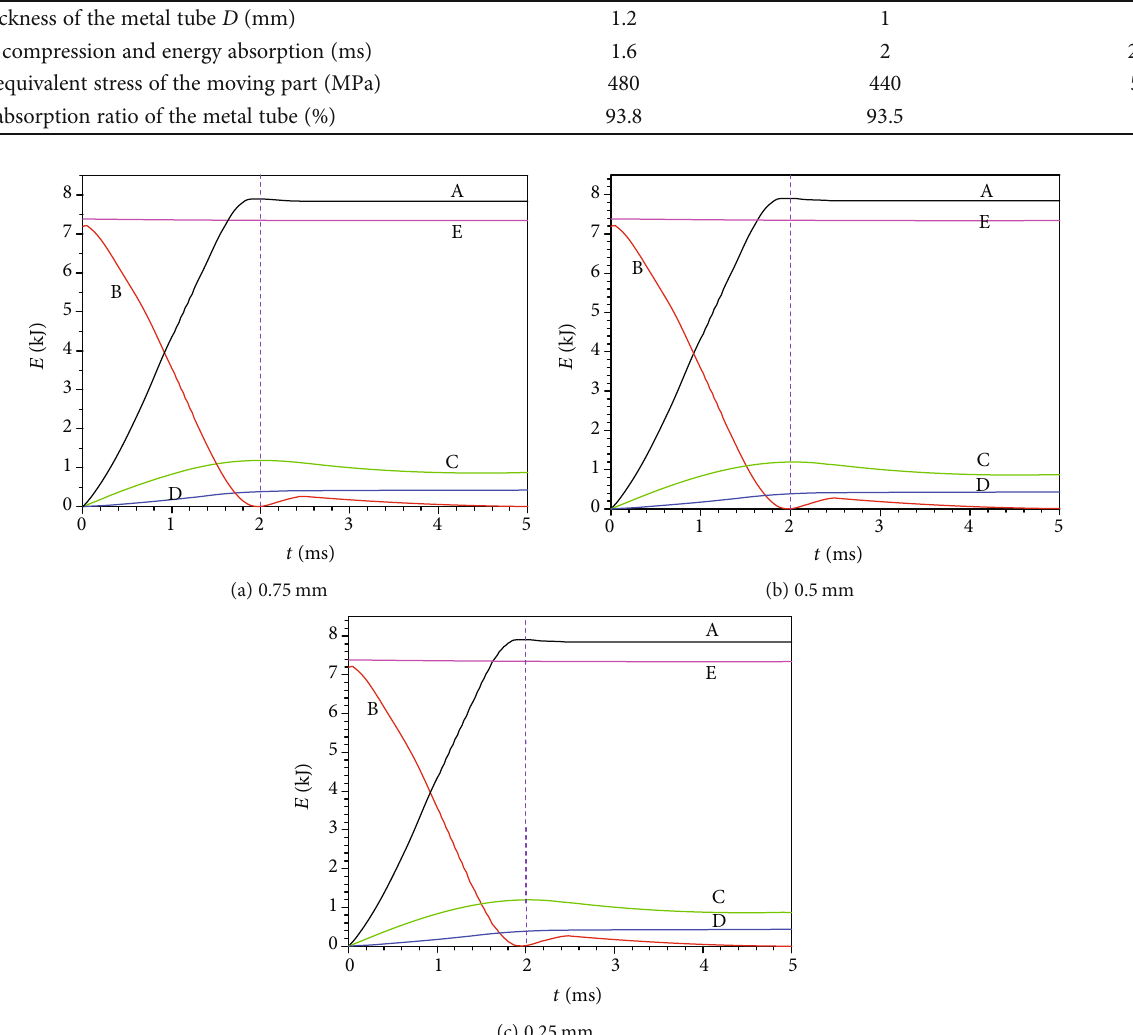
Figure 9: Energy conversion curves in the process of compression and energy absorption of metal tubes located in di ff erent positions. A: internal energy of the metal tube; B: kinetic energy of the ascending object; C: work done by external load; D: frictional energy consumption; E: total energy of the